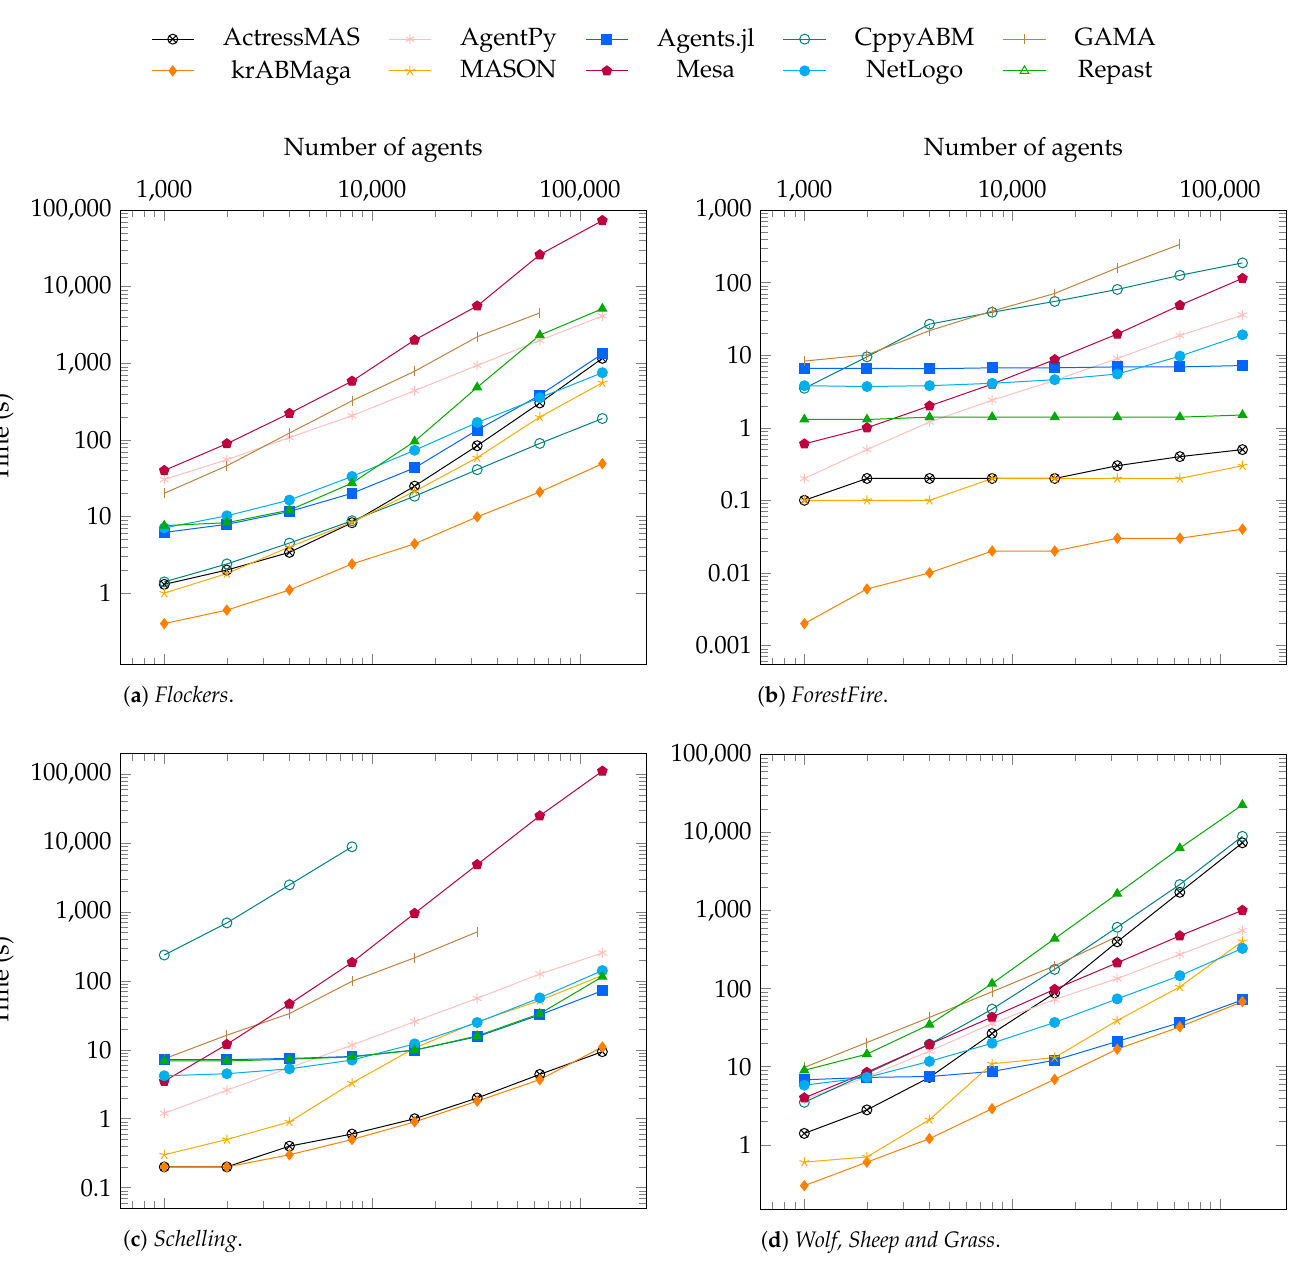
Figure 1. Running times of each framework on the four ABMs, varying the computational load by increasing the number of agents while preserving the agent